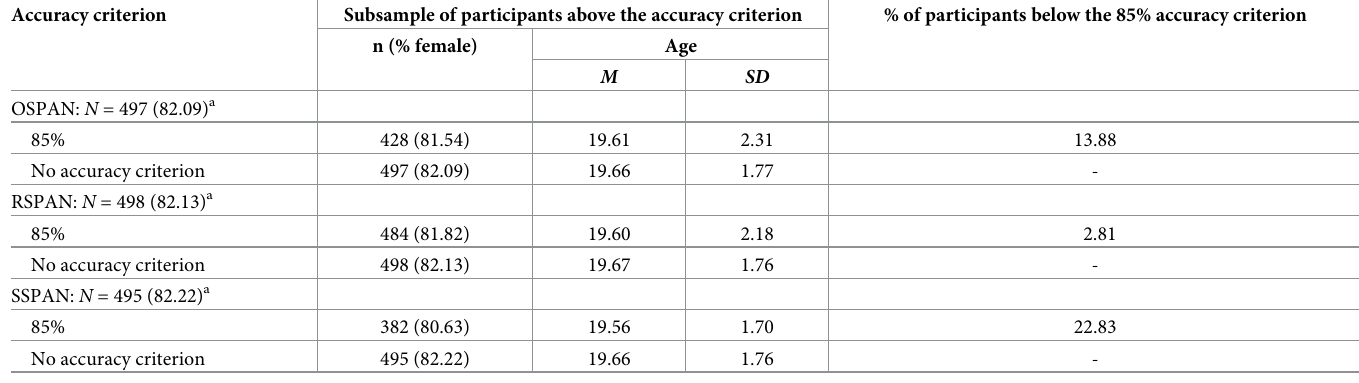
Table 1. Structure of the (sub)samples according to the working memory (WM) span task and the accuracy criterion on the processing component of the task. Accuracy